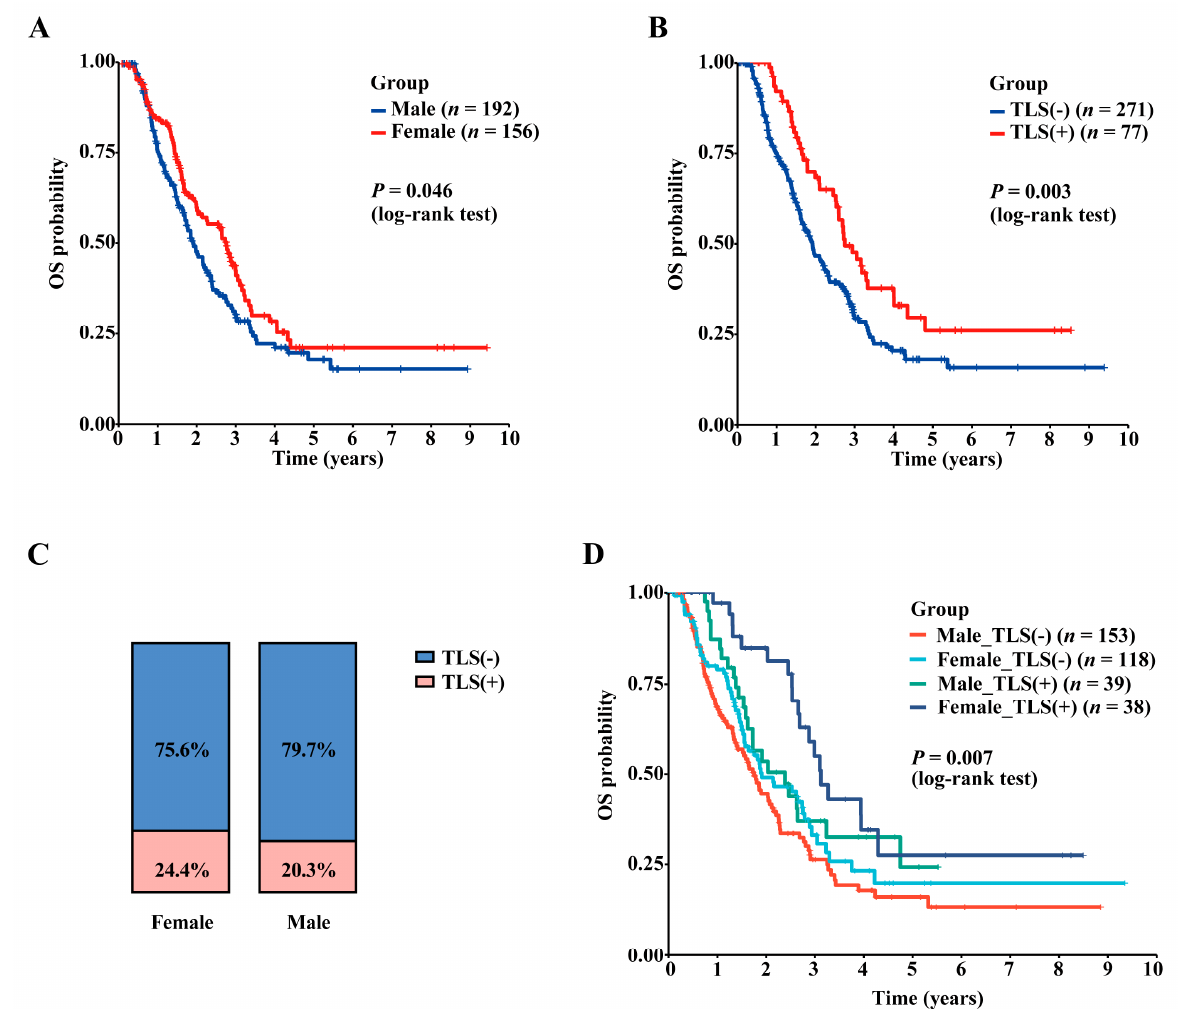
Figure 2. Gender difference of TLS incidences and prognosis in PAAD patients. ( A ) The overall survival curves of male and female PAAD patients. ( B ) The overall survival curves of intratumoral TLS (+) and TLS ( − ) PAAD patients. ( C ) Proportion distribution of TLS (+) and TLS ( − ) samples in different gender groups; p > 0.05, chi-square test. ( D ) Survival curve analysis based on gender and TLS classification.